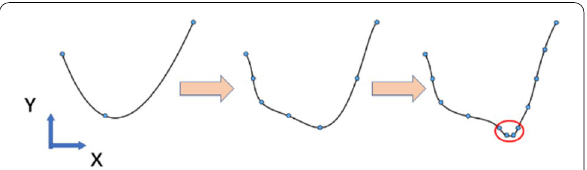
Figure 1 Research ideas of this paper Figure 2 Principle of surrogate model